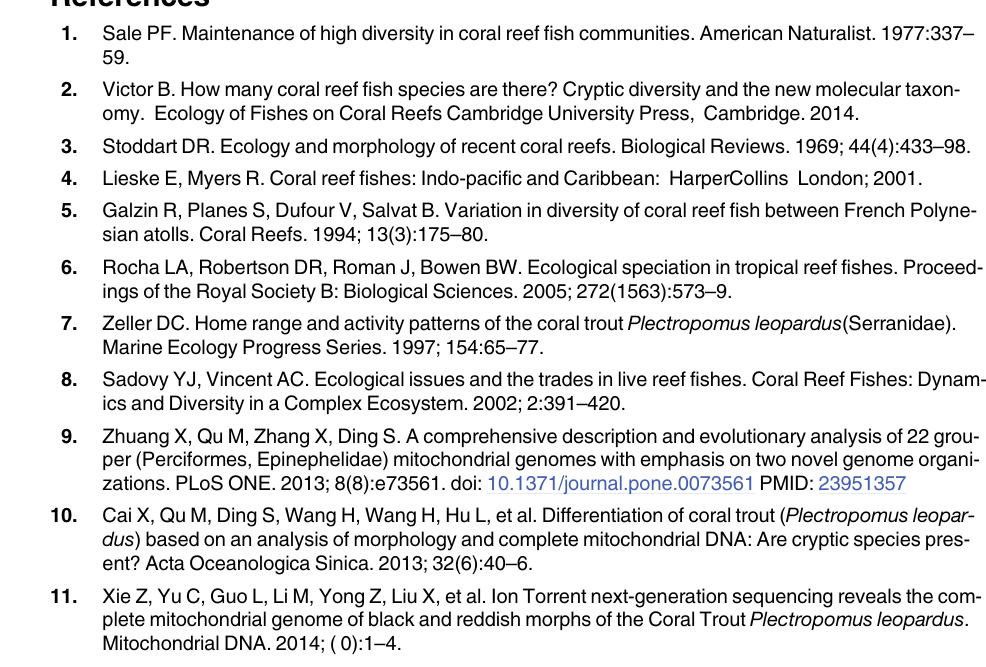
S3 Table. All putative SNPs (130 524) identified in the transcriptomes of black and red common coral trout. S4 Table. 18280 putative SNPs showed different at the same chromosome positions between black and red common coral trout. S5 Table. Candidate genes under positive selection with Ka/Ks more than one between black and red common coral trout. S6 Table. KEGG pathways enriched using candidate genes under positive selection and the number of genes involved in each pathway. S7 Table. KEGG pathways enriched using fast-evolving genes and number of genes involved in each